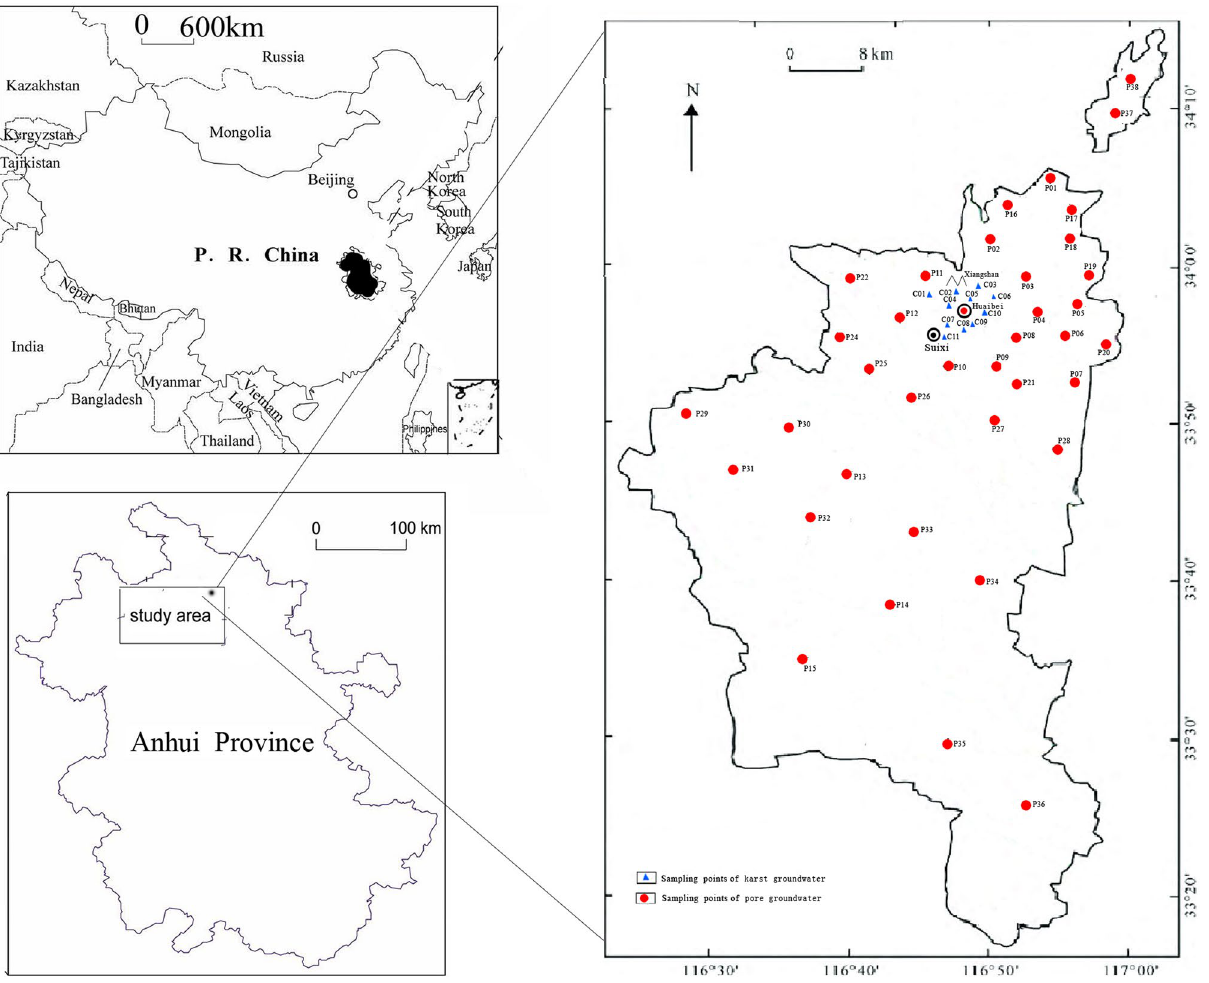
Figure 1. Location map and sampling points of study area (created with the software of Coreldraw